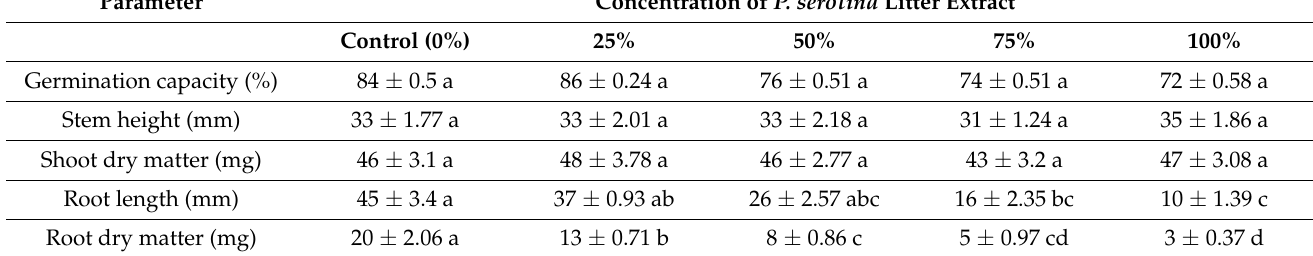
Table 2. The effect of water extracts from Prunus serotina litter with different concentrations on germination and seedling growth of Fagopyrum esculentum . Data are mean ± SE, n = 5. Different letters following values in rows, indicating significant differences for the parameter between control and extract concentrations, were estimated by Tukey HSD test or Kruskal–Wallis test with p ≤ 0.05.